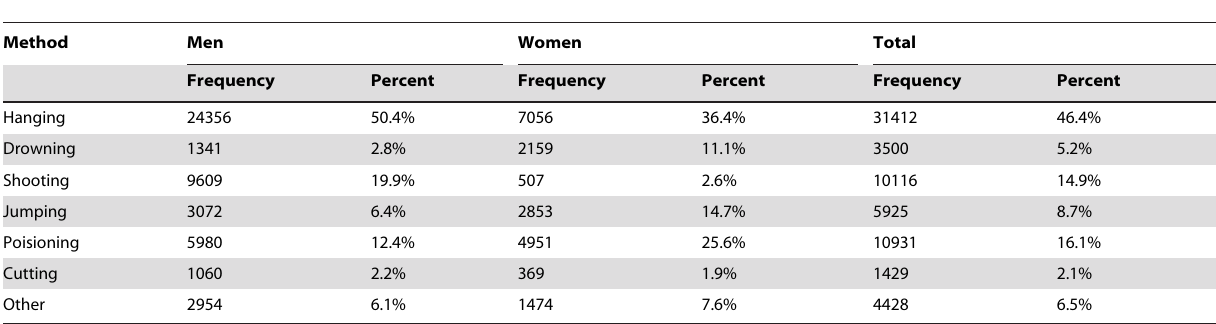
Table 3. Frequencies (absolute and relative) of specific suicide methods in Austria.